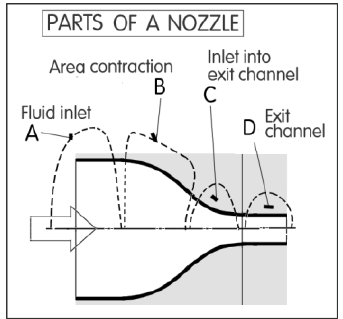
Fig. 2. Component parts of typical low-loss (i.e. smoothly contoured) axisymmetric nozzle. Fluid is accelerated in the area contraction B to counter the slowing down of the generated jet by viscous and vortex momentum transport to